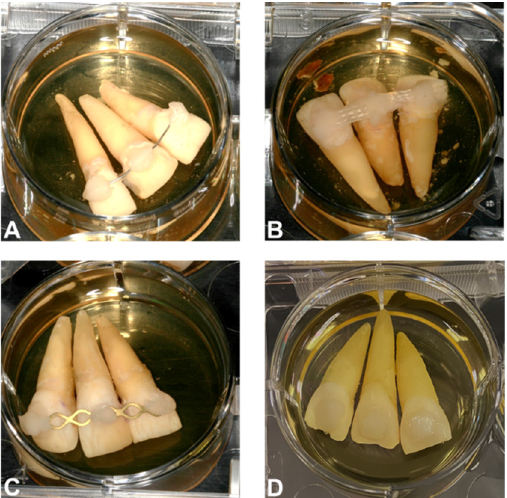
Figure 1. Teeth groups splinted with either ( A ) Orthodontic wire, ( B ) Ribbond, ( C ) Titanium Trauma Splint, or ( D ) Monofilament fishing line. Splinted teeth submerged completely in 3 mL of peptone yeast glucose (PYG) broth and replenished equally as needed.